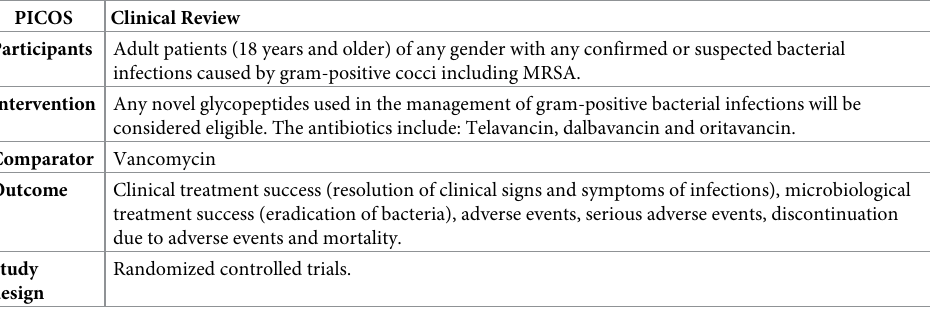
Table 1. PICOS strategy for data extraction of novel